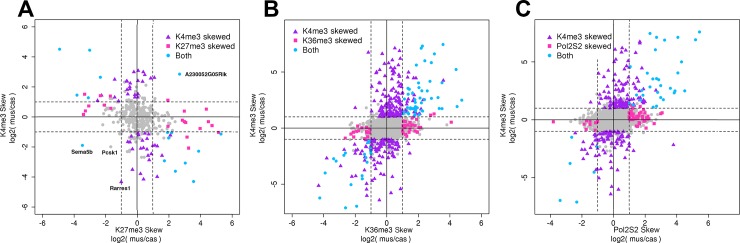
Relationships between the magnitudes of allelic skew of different marks on the same gene.For all genes with sufficient number of allelically assigned reads, allelic skews (log2 of mus:cas ratio) are plotted for one mark vs. another: A, K27me3 vs. K4me3; B, K36me3 vs. K4me3; C, POL2S2 vs. K4me3. Horizontal and vertical dashed lines mark the 2-fold allelic difference. The majority of genes do not show significant skew in any mark (gray points around origin). Most of the genes with skewed chromatin state (colored points) have a skew in only one mark and no significant skew in the other (purple triangles and magenta squares). However, when both marks are skewed (cyan circles), these skews are anticorrelated for active vs. repressive mark (A) and correlated for two active marks (B, C).